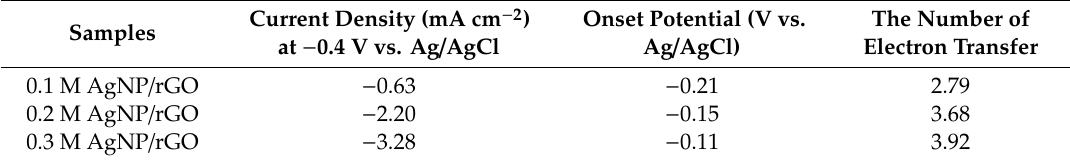
Table 1. Electrochemical data (at 1600 rpm) for 0.1 M AgNP / rGO, 0.2 M AgNP / rGO and 0.3 M AgNP / rGO extracted from linear scan voltammograms, as shown in Figure